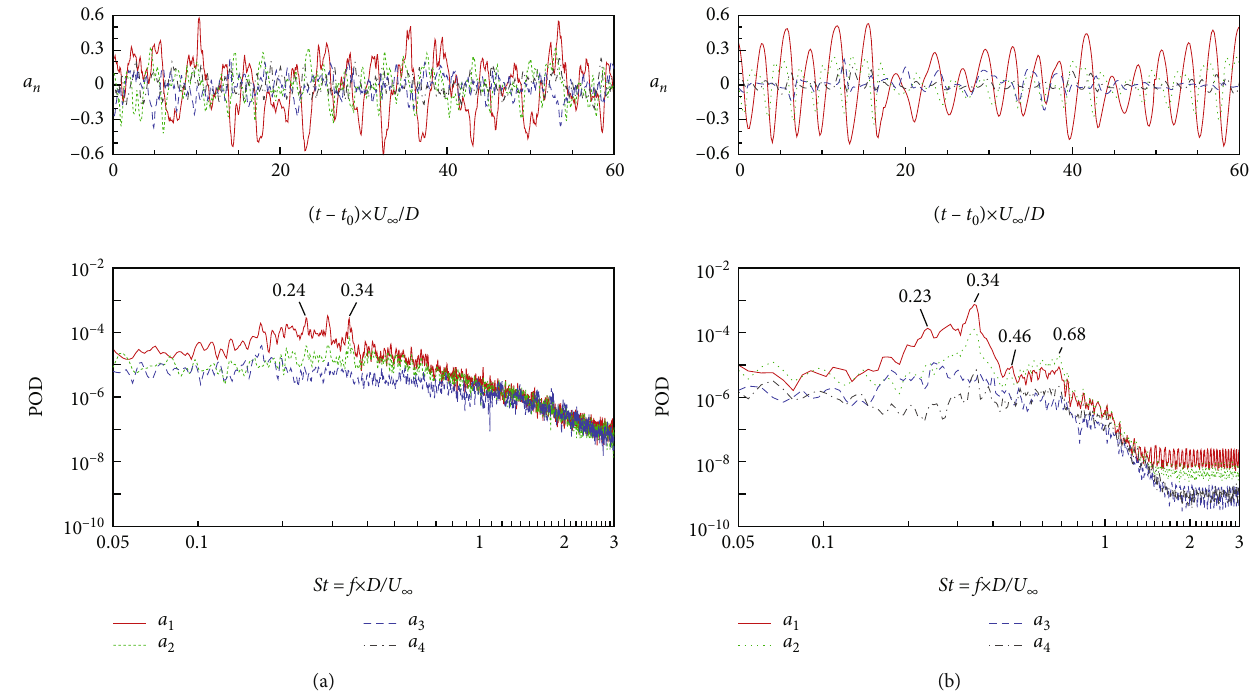
Figure 17: First four POD coe ffi cients and their PSD: (a) experiment and (b)